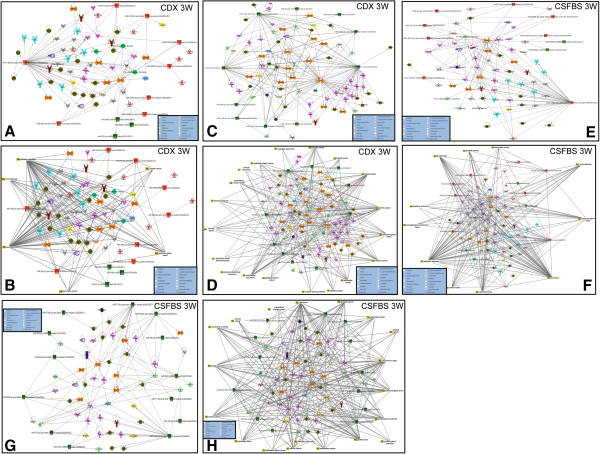
Analysis of miRNA-regulated network of interacting partners involved various signaling pathways. A) Log2 transformed FC values of 21 up regulated miRNAs were imported into the Core analysis tool of IPA software and a network for interacting miRNAs and their direct target proteins and proteins that target any of the up regulated miRNAs has been generated for 3wks CDX treated cells. Red symbols denote miRNAs or mature miRNAs. Proteins include growth factor/cytokines, enzymes, kinases, phosphatases, peptidases, translational regulator, transcriptional regulators, and transporters. B) The network in A is overlayed with disease relationship showing association of miRNA and protein interactions with various types of cancer. C and D) Regulatory network of the log2 transformed FC values of 22 down regulated miRNAs and their target proteins in 3wks CDX treated cells (C) and overlay of disease association of the miRNA-protein regulatory network (D). Green symbols represent down regulated miRNAs and mature miRNAs. E and F) Regulatory network of log2 transformed FC values of the up regulated miRNAs and their target proteins in cells treated with CSFBS for 3wks (E) and an overlay of disease relationship with the regulatory network in E. Red symbols represent miRNAs and mature miRNAs. G and H) Regulatory network of log2 transformed FC values of the down regulated miRNAs and their target proteins in cells treated with CSFBS for 3wks (G) and an overlay of disease association with the regulatory network in G (H). Green symbols represent down regulated miRNAs and mature miRNAs.